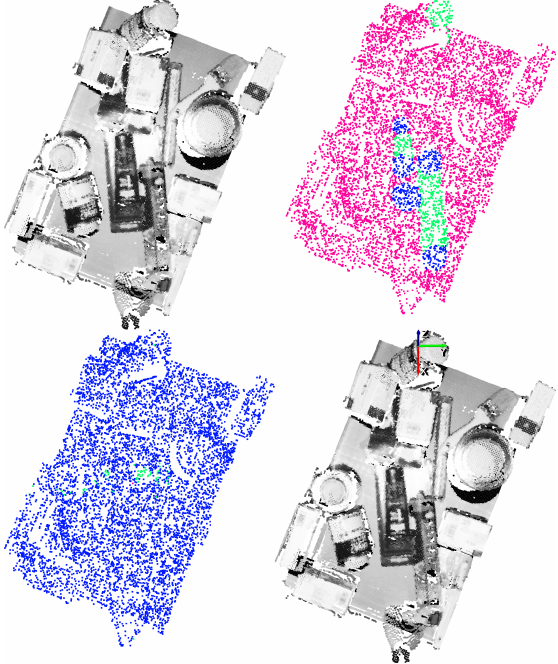
Figure 15. Gripper result example for n = 5. Top-left: point cloud of the scene. Top-right: ground- truth annotation. Bottom-left: Top-1% predictions. Bottom-right: Top-1 grasping point. The vertical orientation for the gripper is determined by the y (green)